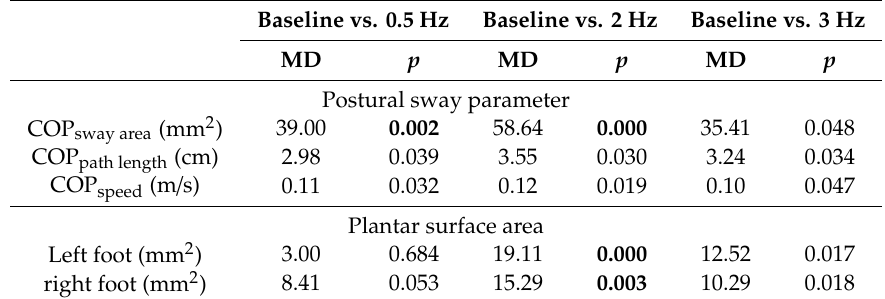
Table 3. Post hot test for intra-saccadic eye movement (SEM) frequency pair-wise